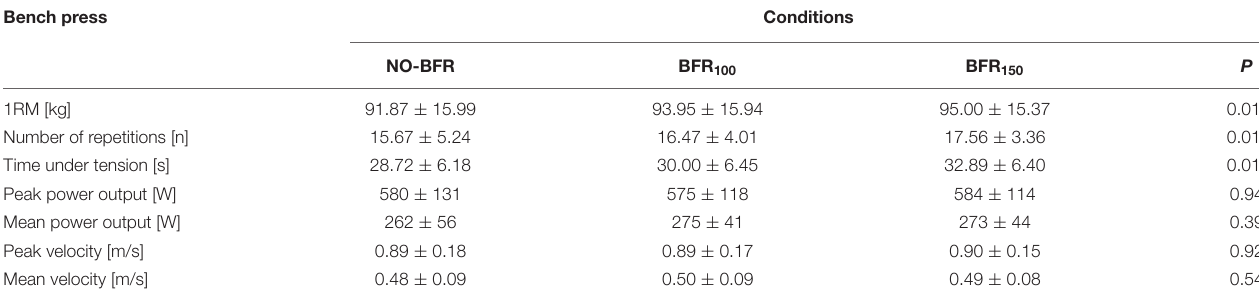
TABLE 1 | Main conditions effect in the 1RM test and during three sets of the bench press under the three employed conditions. Bench press